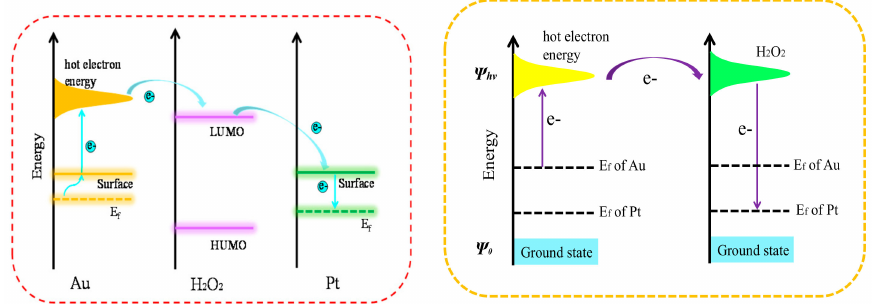
Figure 4. Schematic of work-function-driven electron transfer from the surface of Au to the surface of Pt.